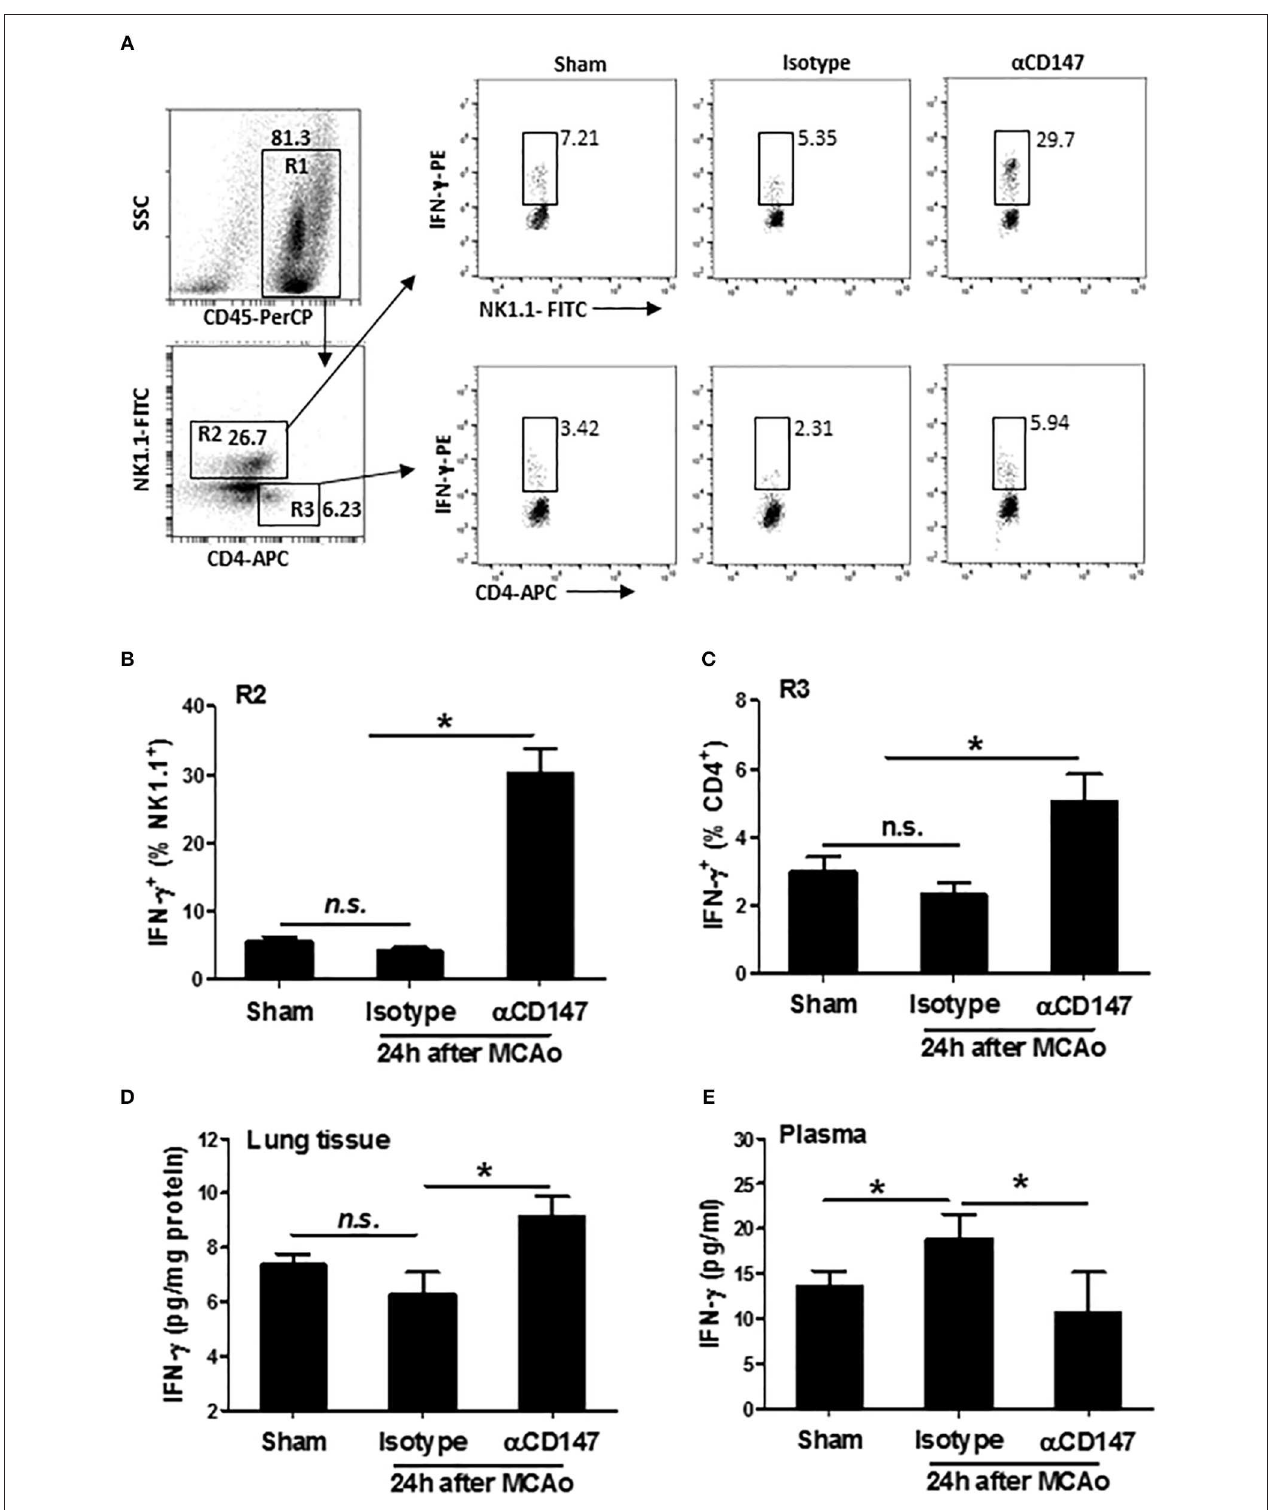
FIGURE 6 | Inhibition of CD147 increases lung, but not plasma IFN- γ expression after stroke. (A) Representative flow cytometry strategy for gating and identifying IFN- γ -producing NK1.1 cells (R2: CD45 + NK1.1 + CD4 − ) and CD4 + T cells (R3: CD45 + NK1.1 − CD4 + ). Lung infiltrating-cell was isolated at 24h after stroke. (B,C) Quantification of lung IFN- γ -producing NK1.1 + cells (B) and CD4 + T cells (C) in the indicated groups. n = 6 per group. (D,E) ELISA assay of IFN- γ protein concentration in the lung tissue (D) and plasma (E) at 24h after stroke. n = 6 per group. n.s. indicates not statistically significant. * P < 0.05.